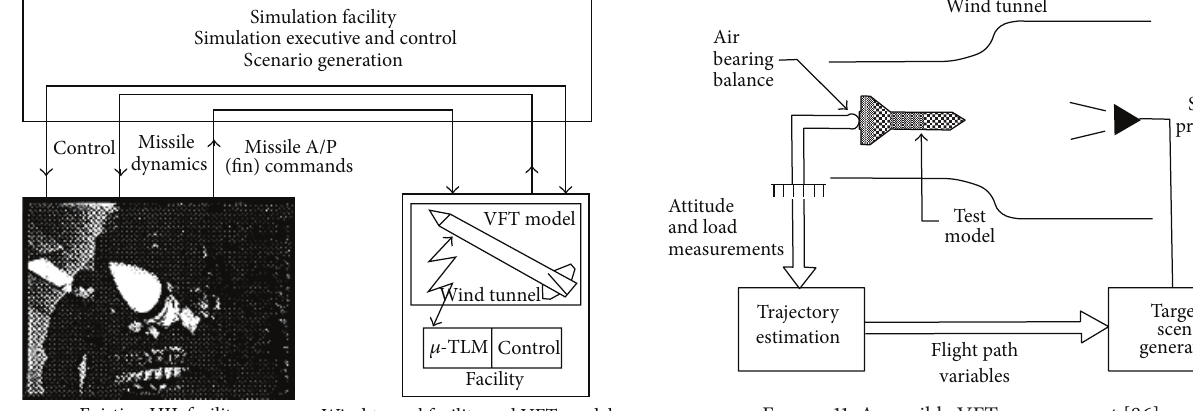
Figure 11: A possible VFT arrangement